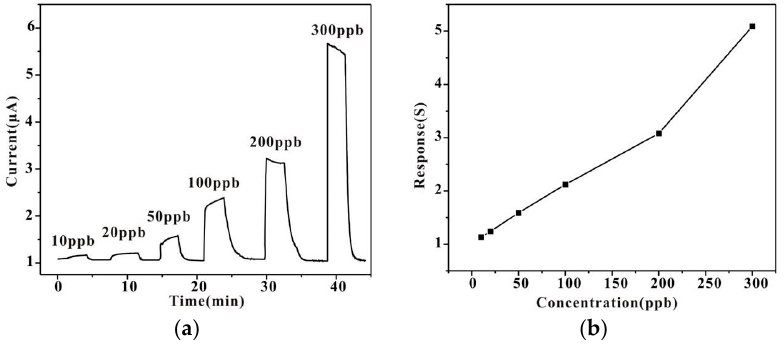
Figure 10. ( a ) Responses of the Au-modified HPSCZNs structures to different concentrations of TMA and ( b ) the corresponding calibration curve.